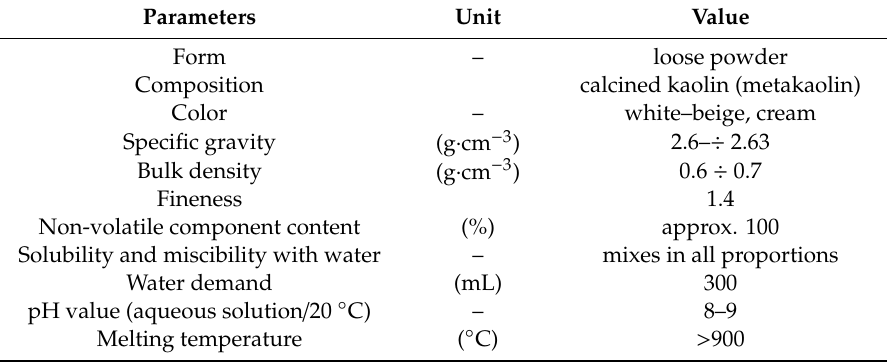
Table 7. Technical data of the reactive powder (on the basis of the manufacturer’s information [49]).